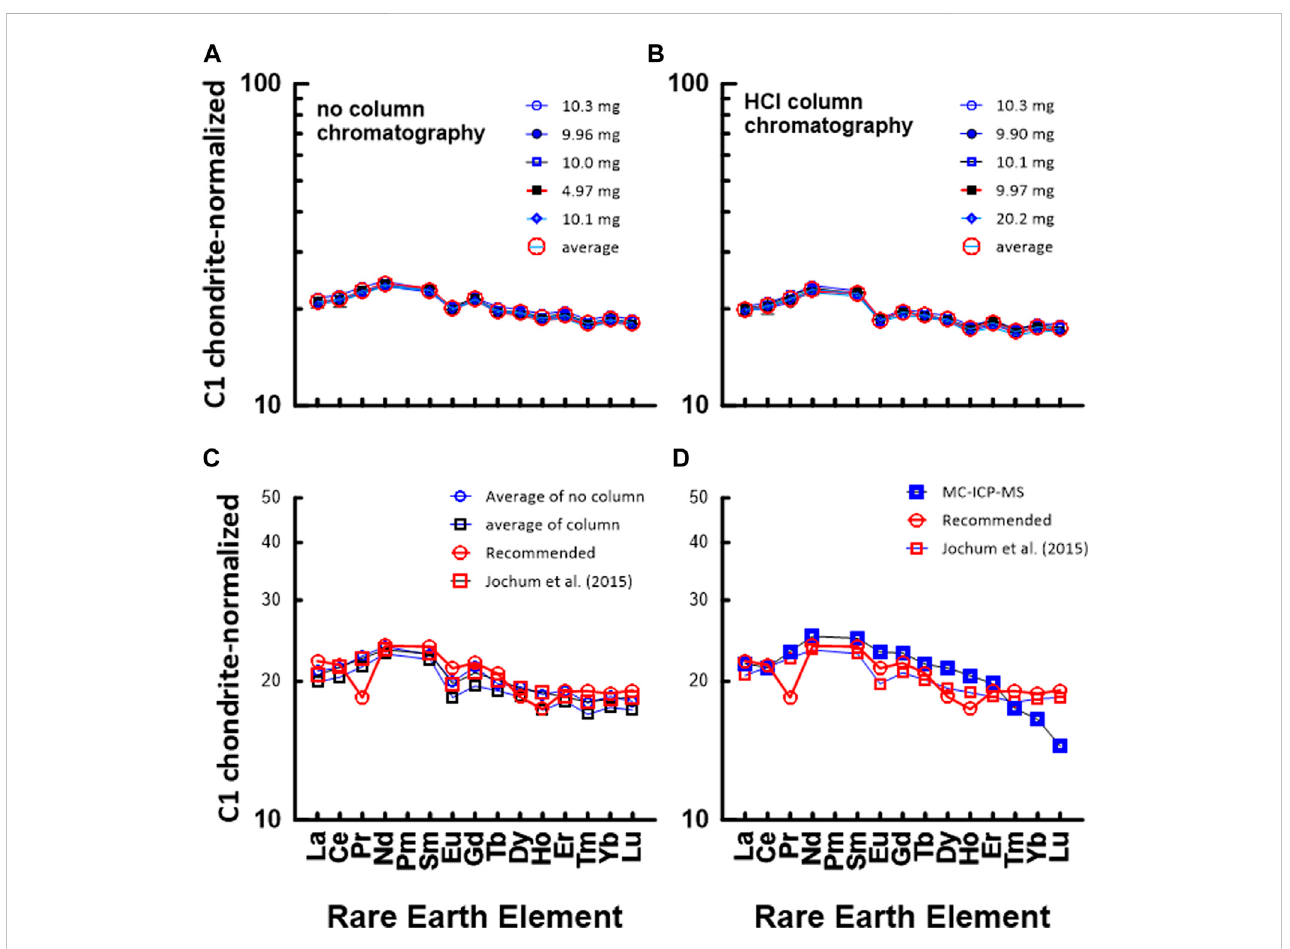
FIGURE 5 C1 chondrite-normalized REE patterns of JA1: (A) measured by conventional ICP-MS method without HCl column chromatography in this study and (B) measured by conventional ICP-MS method after HCl column chromatography in this study. The numbers in (A) indicate the gravity weight of sample. (C) comparison with the data measured by ICP-MS in this study and recommended value by GSJ, (D) comparison with the data measured by ICP-MS in this study and recommended value by